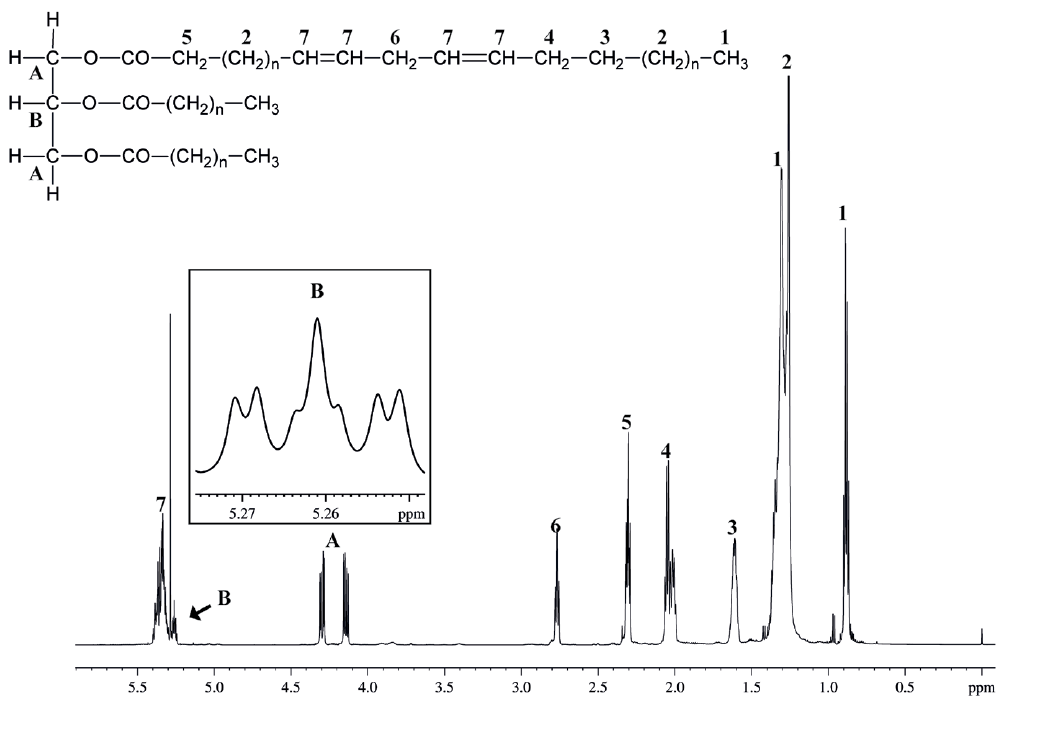
FIGURE 1 – 1 H qNMR spectrum of Annona salzmannii seed